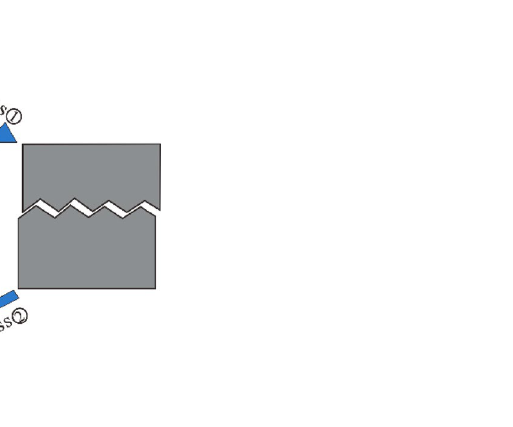
Figure 3. Cyclic shear process of the joint